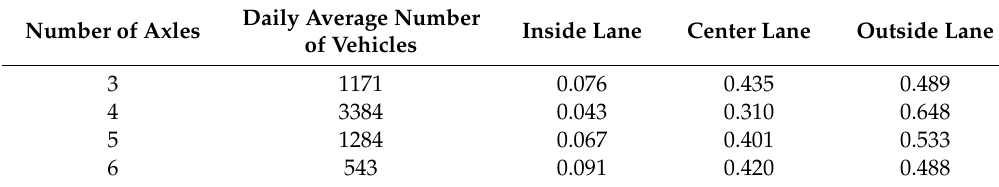
Table 10. Lane distribution coefficient of multi-axle vehicles.